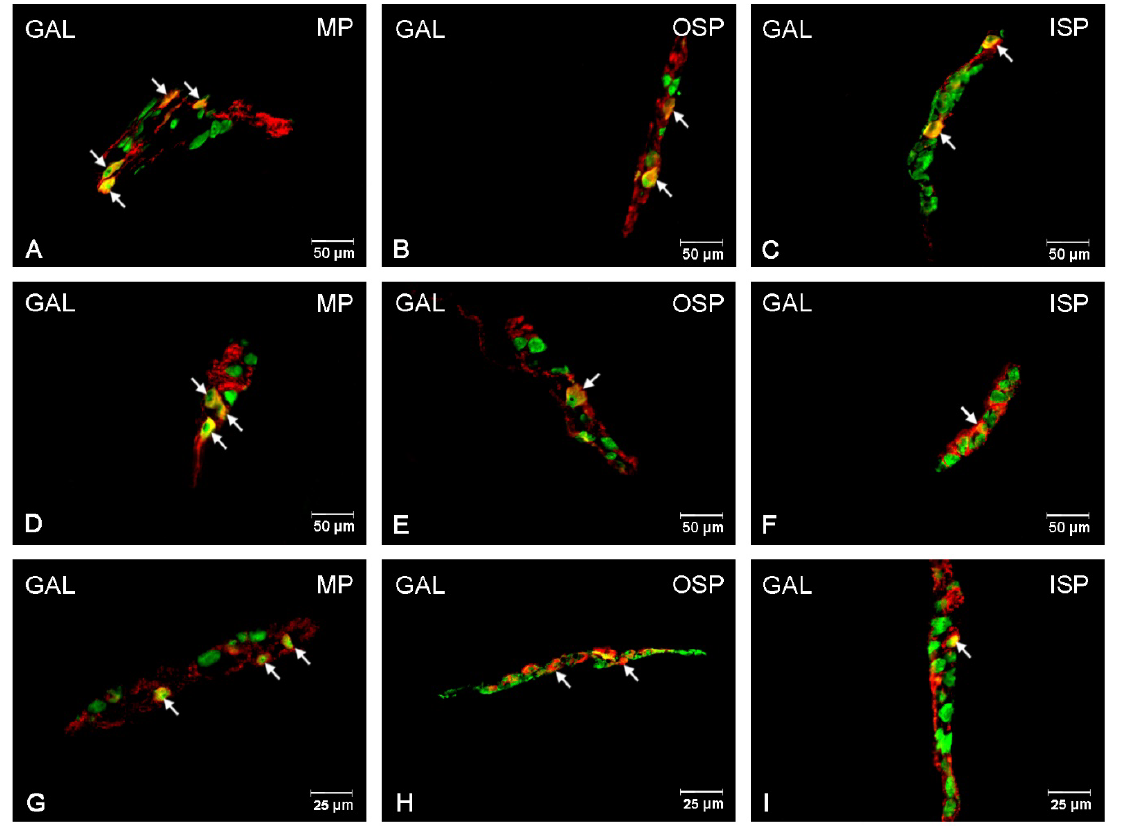
Figure 8. Fluorescence microscopy images showing protein gene product 9.5 (PGP 9.5) visible as green fluorescence that colocalizes with galanin (GAL) visible as red fluorescence in the enteric neurons of the jejunum in pigs. The obtained images were created by computer superimposition of two channels (green and red). The photos show the enteric nervous system neurons of the pig’s jejunum under physiological conditions ( A , D , G ) and after administration of low ( B , E , H ) and high ( C , F , I ) doses of acrylamide. Neurons immunoreactive for particular substances are advisable with arrows. MP—the myenteric plexus; OSP—the outer submucosal plexus; ISP—the inner submucosal plexus. 3.5. SP-Immunoreactive Neurons SP-positive neurons in the control group were most abundant in the OSP: 25.62 (±0.95) %, while in the ISP, their number was considerably smaller and amounted to 10.14 (±0.44) %, and in the MP, this population only amounted to 0.92 (±0.22) % [Figures 9 and 10A–I]. Following low-dose acrylamide administration, an increase in the population of SP-positive neurons was only observed in the MP: 1.21 (±0.14) % [Figure 10D]. However, a high dose of acrylamide increased the number of SP-expressing neurons in both the MP: 2.35 (±0.41) % [Figure 10G] and in both submucosal plexuses: in the ISP, up to 20.58 (±1.54) % [Figure 10I], and in the OSP, to 34.81 (±0.93) % [Figure 10H].